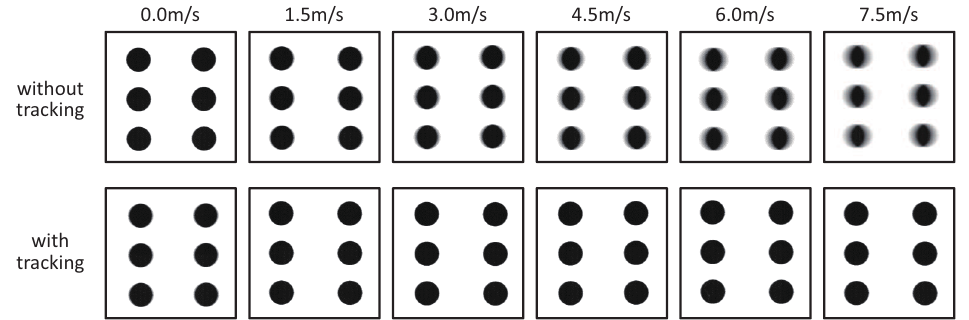
Figure 16. Images of a circle-dot pattern when video shooting with amplitude control.